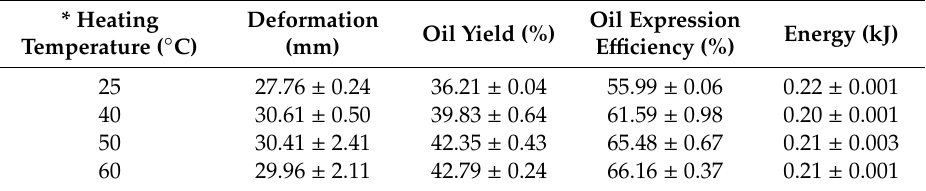
Table 2. E ff ect of heating temperature on deformation, oil yield, oil expression e ffi ciency, and energy.